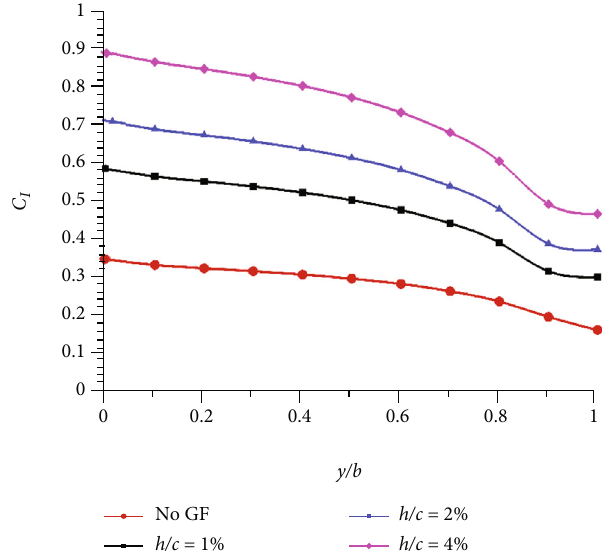
Figure 9: E ff ect of GF height on sectional lift coe ffi cient at α = 0 ° .